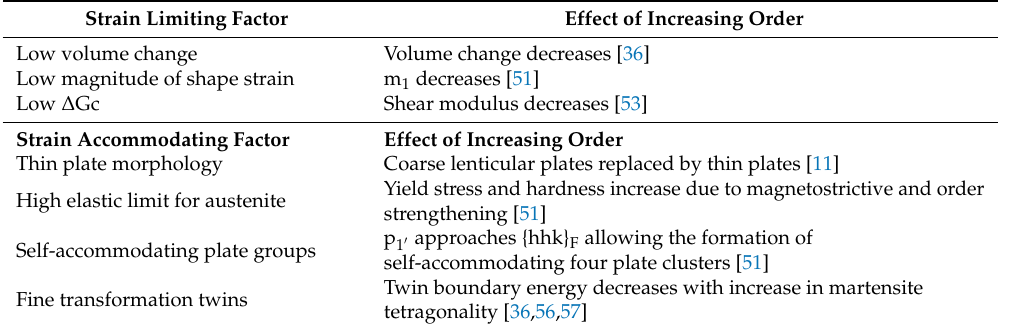
Table 1. Factors contributing to reversible martensitic transformation in Fe 3